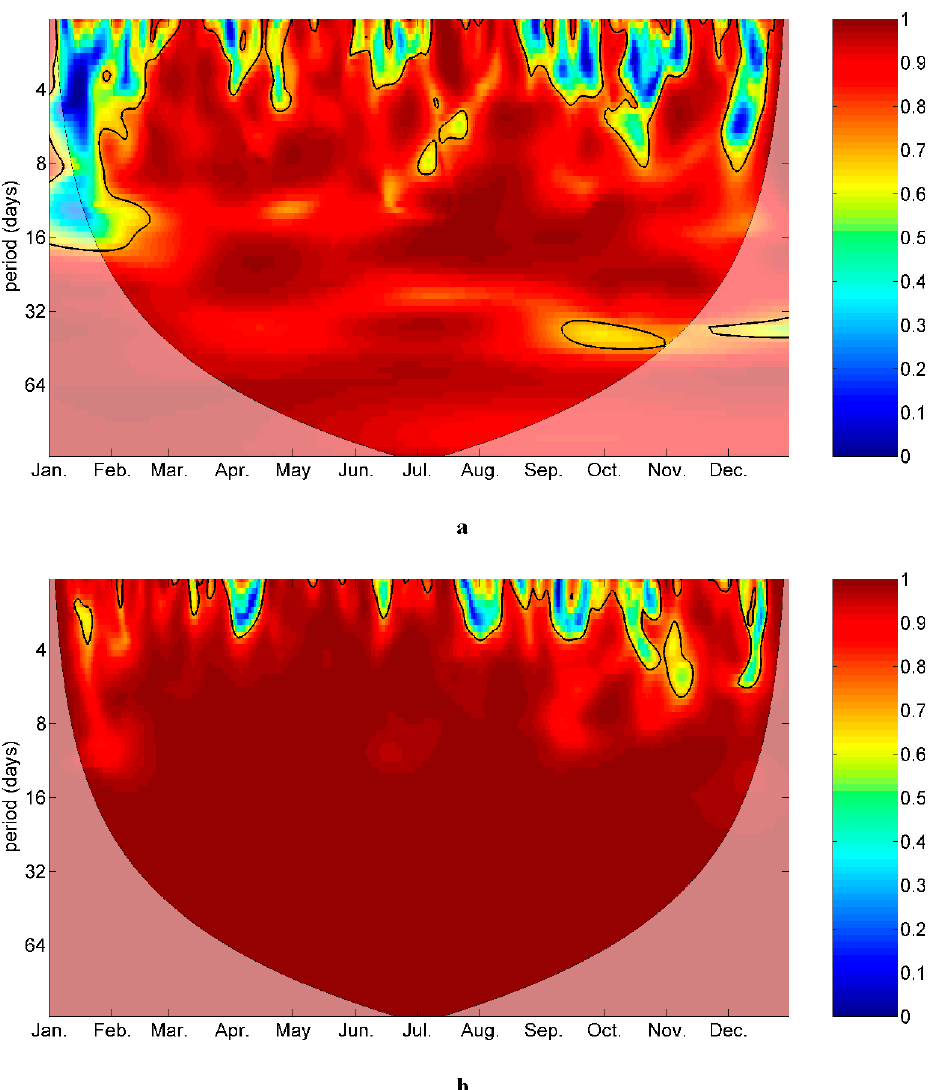
Figure 12. Multiple wavelet coherence analysis scalograms between Suceava river water temperature and air parameters: ( a ) water temperature upstream versus air temperature at Suceava Weather Station and water level upstream, ( b ) water temperature downstream versus air temperature in the floodplain and water temperature upstream.